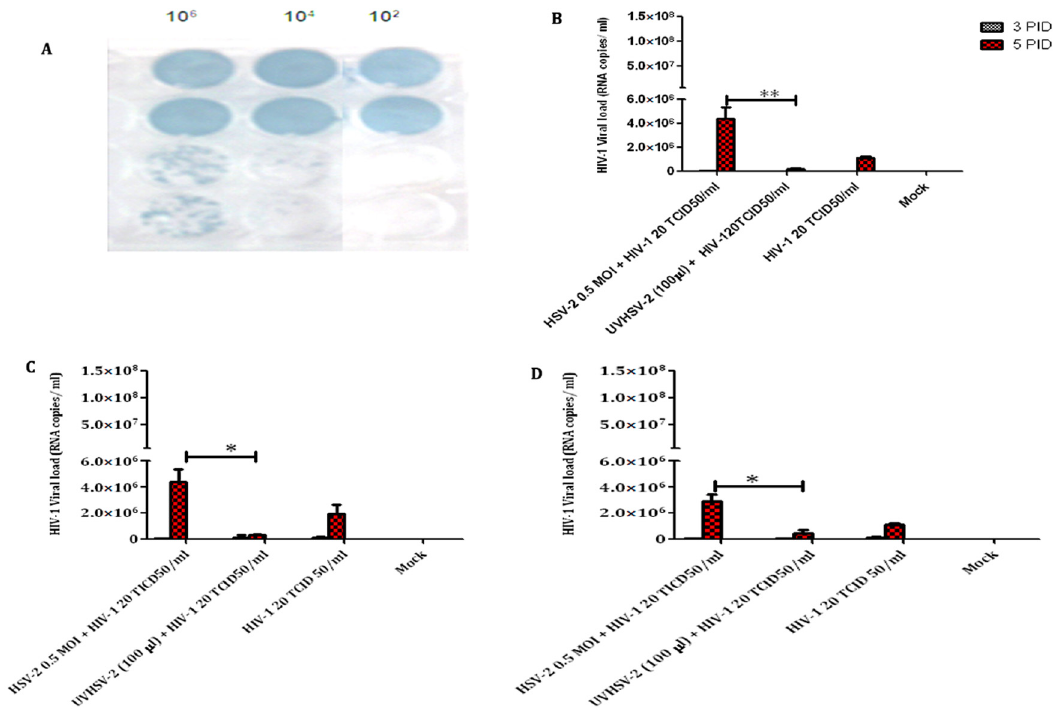
Figure 2. Effect of UV-inactivated HSV-2 on HIV-1 viral copy number in T-cells in vitro. Vero mono- layer infected with UV-inactivated HSV-2 (top) and live replication-competent HSV-2 (bottom) ( A ). HIV-1 viral copy number/mL in culture supernatants of T-cell lines; CEM CCR5+ ( B ), A3R5.7 ( C ) and primary CD4+ T-cells ( D ) in co-infection assays. HIV-1 viral copy numbers were estimated using the automated Abbott Real-Time Platform. Data represent mean ± SD of two independent assays. * indicates significant difference with p value < 0.05 while ** indicates p value < 0.01.